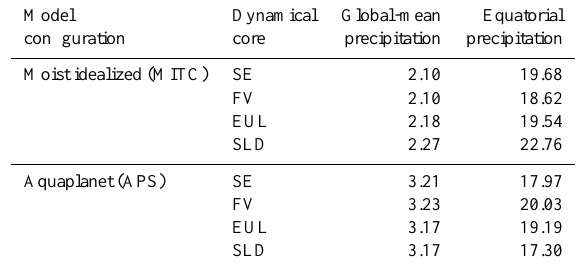
Table 3. Comparison of the time-mean global-mean total precipi- tation rates (PRECT) and the time-mean zonal-mean precipitation rates closest to the Equator in units mmday − 1 . All four CAM5 dy- namical cores are listed in MITC and APS